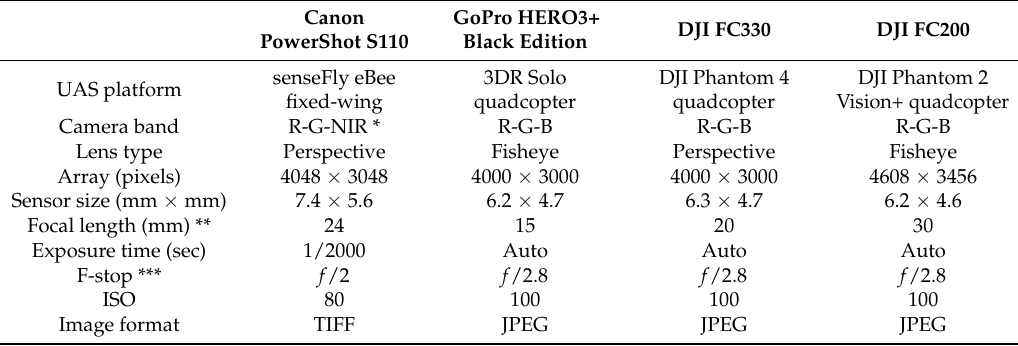
Table 1. Image features of the cameras carried by the unmanned aircraft system (UAS) platforms.